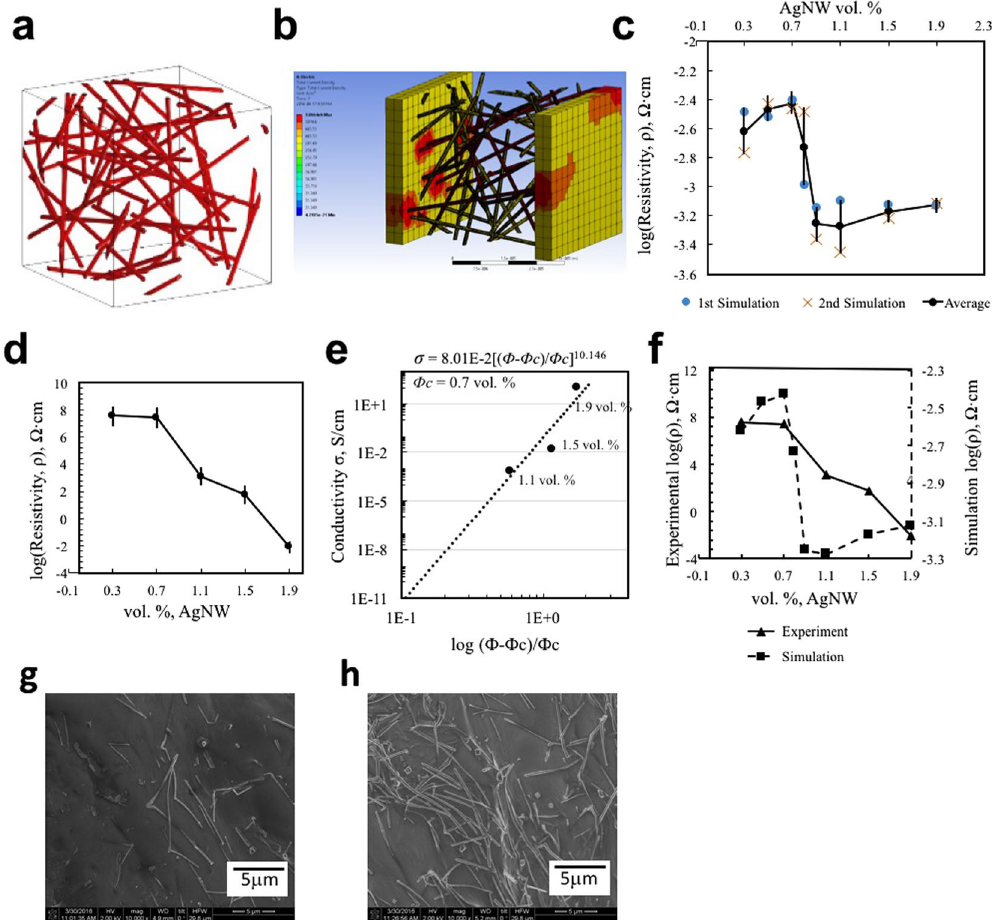
Figure 2. Computational Design and Percolation Evaluation of 3D Conductor and Experimental Percolation Threshold of 3D Conductor ( a ) Generated geometry of AgNW/CMC 3D Conductor by Digimat, ( b ) Image of computational simulation with ANSYS Workbench. Red colored area represents higher current density, ( c ) Simulation result of resistivity change with different AgNW concentrations. ( d ) Resistivity plot of the 3D Conductor. ( e ) Power law plot behavior of the 3D Conductor. ( f ) Comparative plot of electrical resistivity from experiment and simulation with different AgNW concentrations. ( g ) SEM image of 0.3 Vol. % AgNW in CMC, ( h ) SEM image of 1.9 Vol. % AgNW in